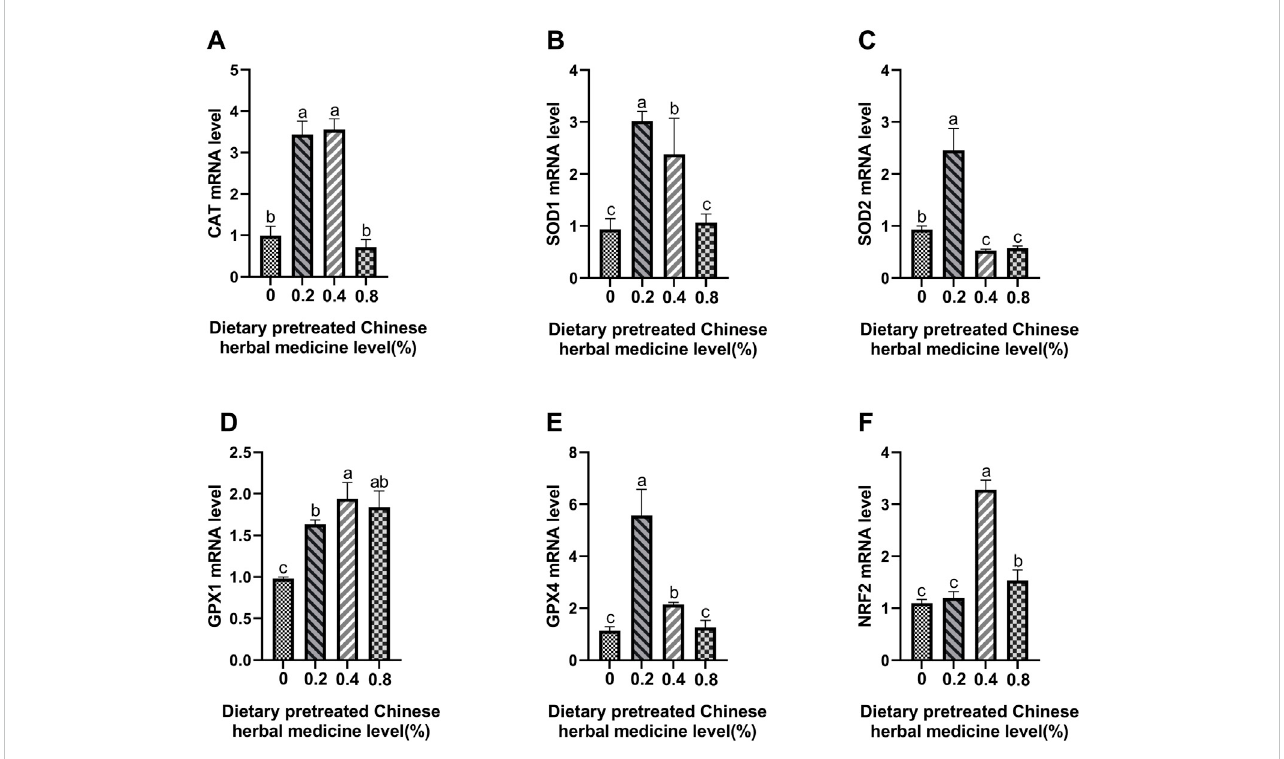
FIGURE 8 EffectsofdietaryPCHMsupplementationonantioxidation-relatedmRNAexpressioninuterus.TheeffectofaddingPCHM(0,0.2%,0.4%,0.8%)indietsin the uterus, measured by quantitative PCR: (A) CAT , (B) SOD1 , (C) SOD2 , (D) GPX1 , (E) GPX4 , and (F) Nrf2 . Values are expressed as means ± SEM of six birds per treatment. Means without a common letter differ ( p <